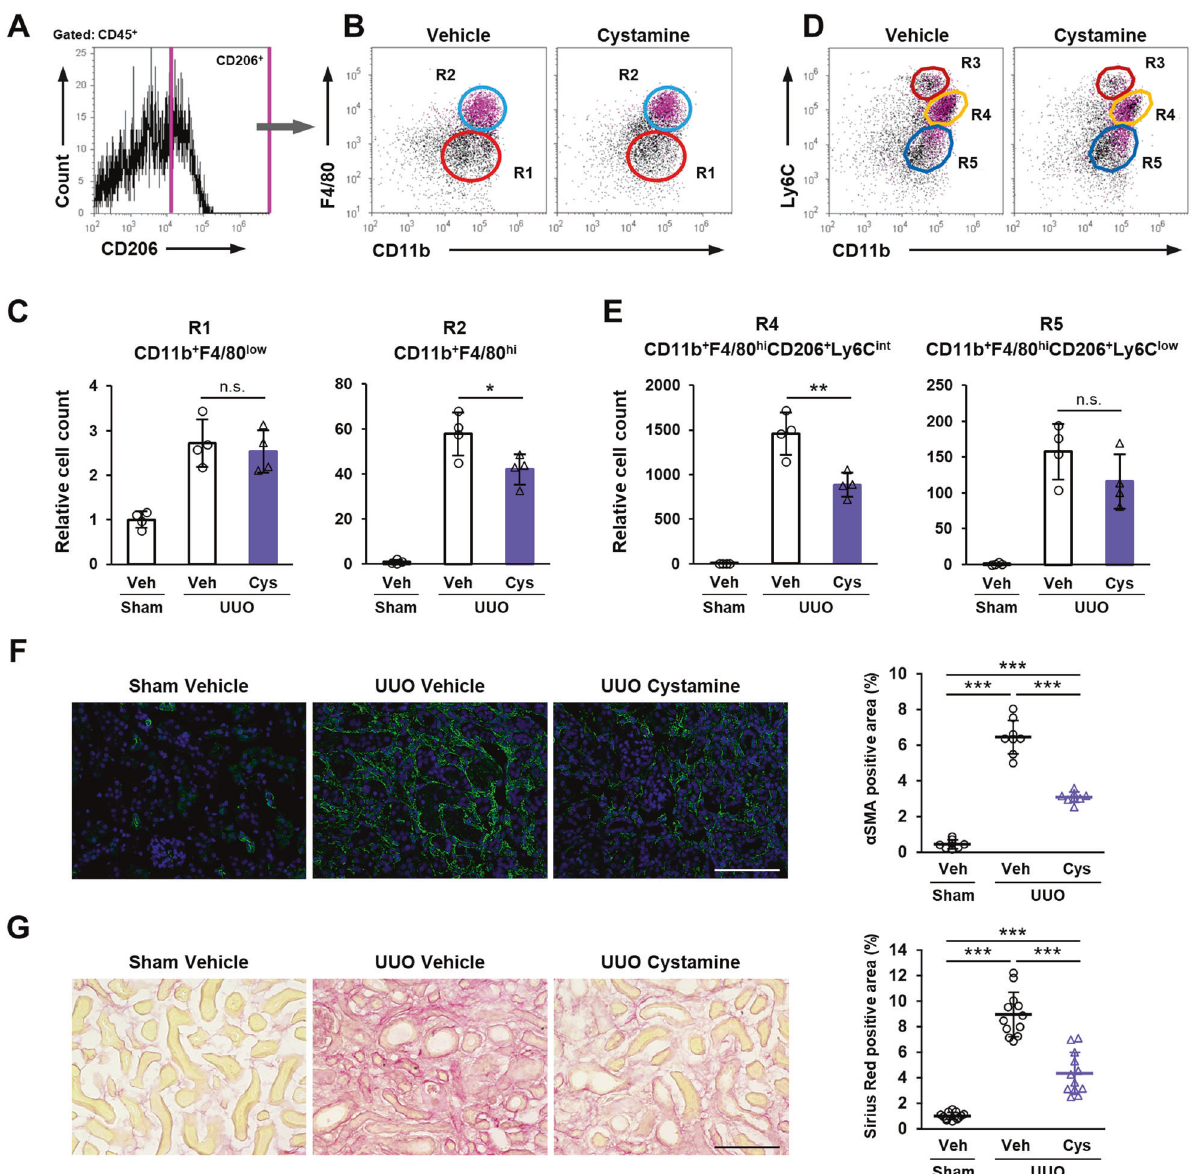
Fig. 5 Effect of cystamine administration in M2 macrophage polarization and renal fi brosis. Mice were conducted to UUO surgery and orally administrated with cystamine (1.86 mg/kg/day). Renal CD45-positive cells were classi fi ed by CD206 ( A ) and colored with magenta in the dot plots divided into the CD11b + F4/80 low (R1) and CD11b + F4/80 hi (R2) groups ( B ). The relative cell counts of R1 and R2 groups were indicated ( C ). These cells also divided into CD11b + Ly6C hi (R3), CD11b + Ly6C int (R4), and CD11b + Ly6C low (R5) groups ( D ). The relative cell counts of R4 and R5 groups gated by F4/80 hi and CD206 + were indicated ( E ). The myo fi broblasts and collagen fi bers in kidney sections were detected by immuno fl uorescence staining using anti- α -SMA antibody ( F ) and picrosirius red staining ( G ), respectively, and the percentages of their positive area are presented in the graph on the right. The nuclei were counterstained with DAPI. Scale bars = 100 μ m. Representative results in at least three independent samples were shown. * P < 0.05, ** P < 0.01, *** P < 0.001 by one-way ANOVA with post hoc Tukey ’ s multiple comparisons